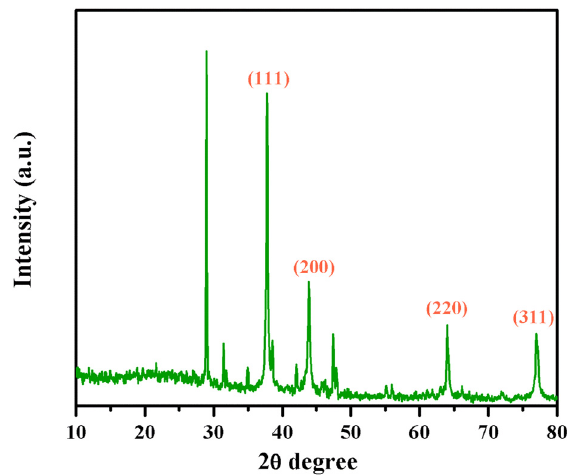
Figure 2: XRD patterns of synthesized Ar -